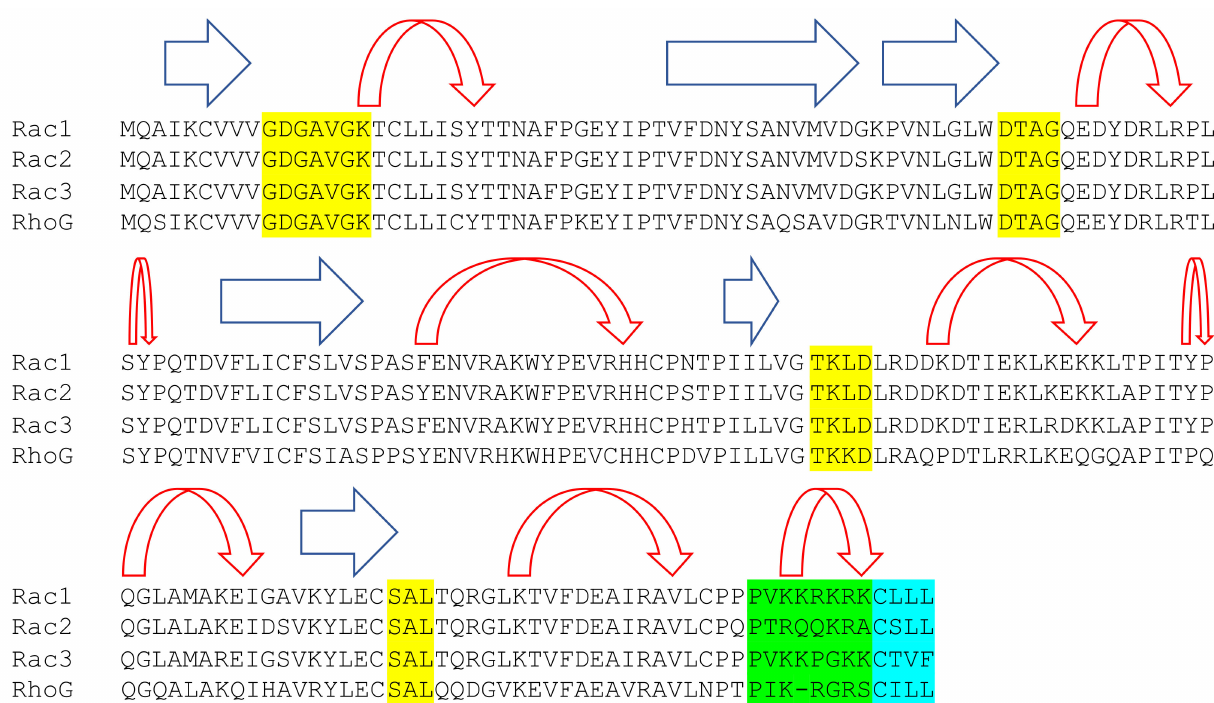
Figure 2. Rac family proteins demonstrate 92% sequence homology between Rac1, Rac2, and Rac3 and 72% homology between RhoG and the other Racs. Human sequence alignments for Rac1, Rac2, Rac3, and RhoG. Secondary structures are illustrated above the sequences with beta sheets denoted by blue arrows and alpha helixes denoted by red arrows. GTP binding and hydrolysis domains (highlighted in yellow) are 100% conserved. The hypervariable region is highlighted in green. The CAAX box (light blue) is recognized by geranylgeranyl